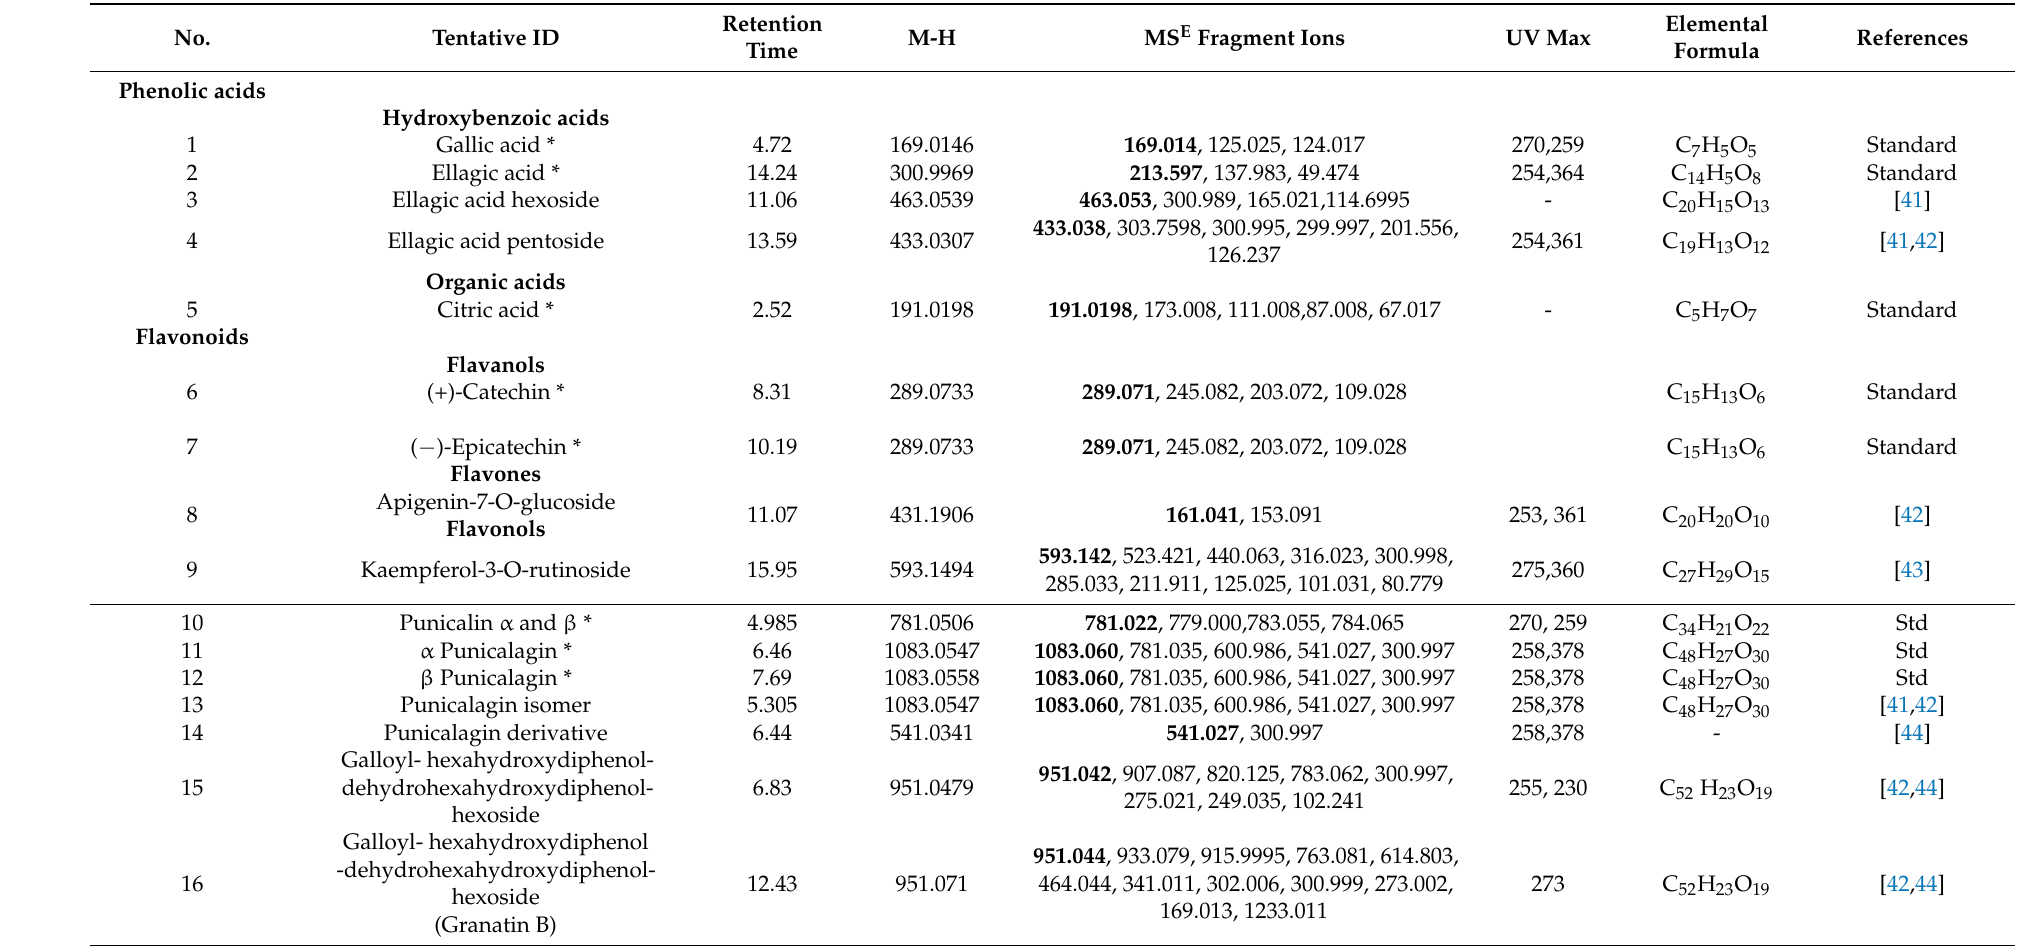
Table 5. Individual phenolic and flavonoid concentration in blanched pomegranate peel (‘Wonderful’ unripe, ripe, and over ripe harvest